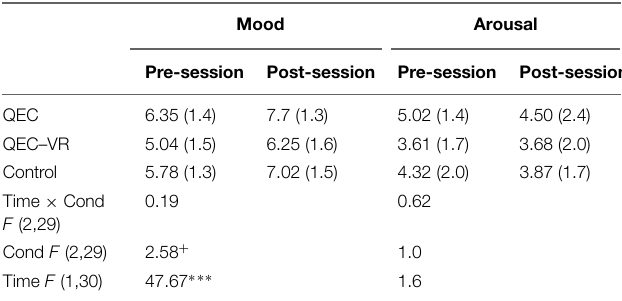
TABLE 2 | Pre- and post-session mood and arousal aggregated across three sessions.